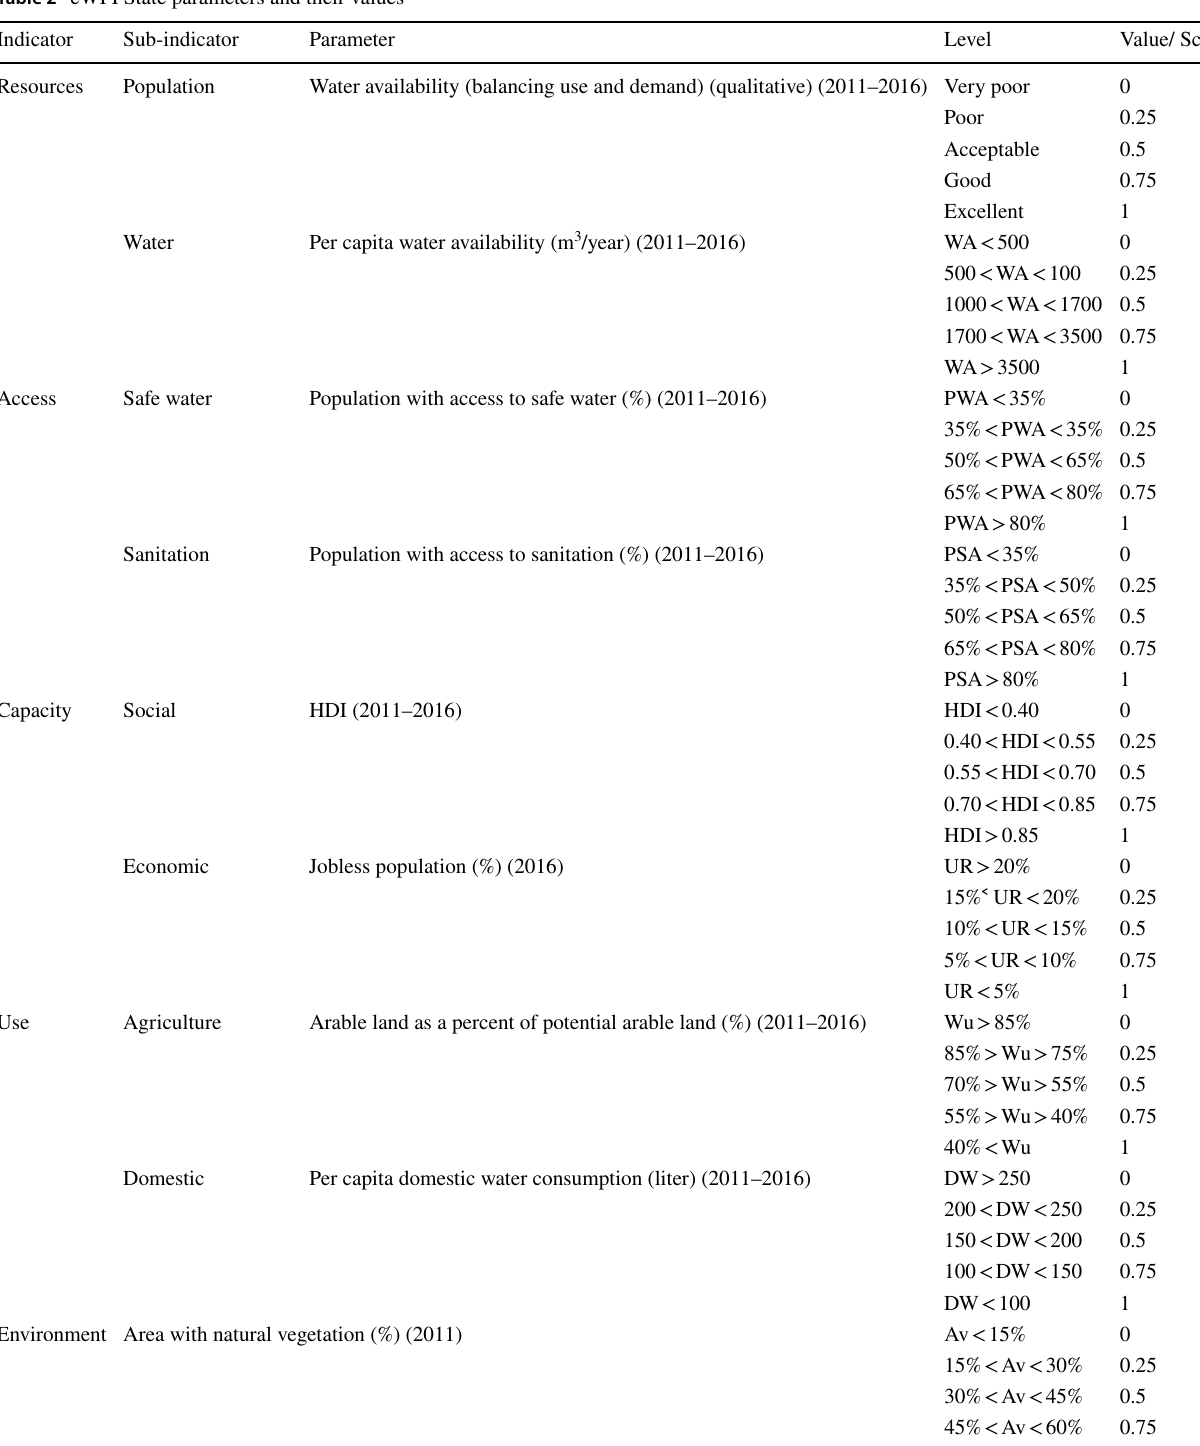
Table 2 eWPI State parameters and their values Indicator Sub-indicator